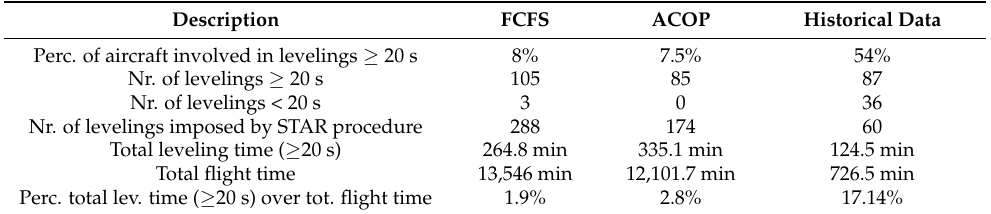
Table 4. CDO-like results.